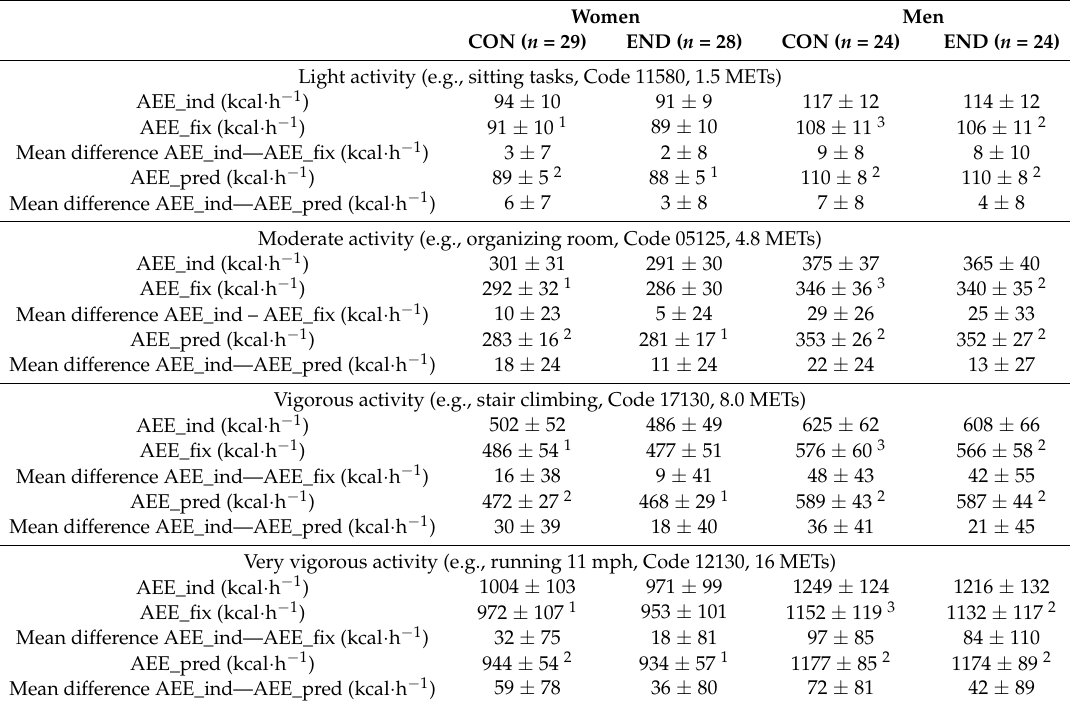
Table 3. Calculation of activity energy expenditure (AEE) for one hour of activity (either light, moderate, vigorous, and very vigorous) by multiplication of the individual (AEE_ind), conventional (AEE_fix), and predicted (AEE_pred) 1-MET value with published MET values of specific activities [9]. Data are presented as Mean ± SD.